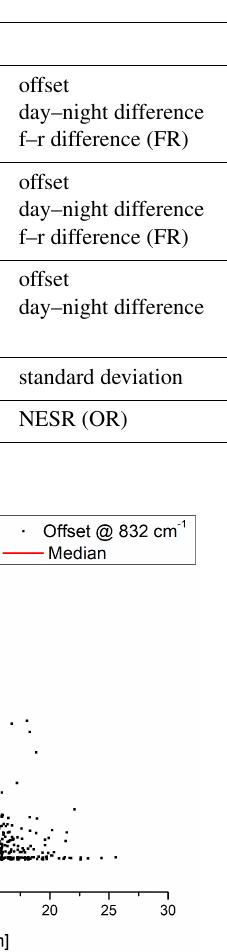
Table 2. Offset values determined from calibrated spectra. f–r is forward and reverse. All values are in nWcm − 2 sr − 1 cm.